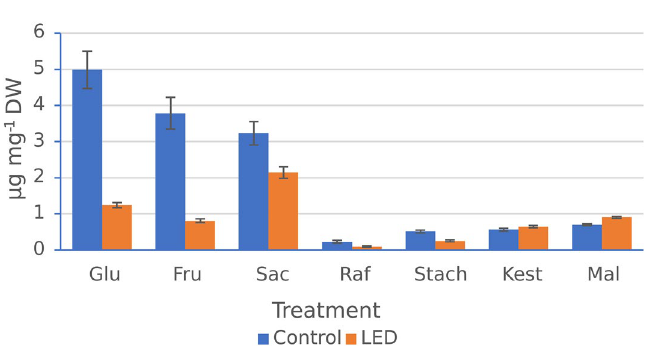
Figure 2. Individual sugar content in leaves of common buckwheat cv. ‘Panda’ under different controlled- environment production systems. Control—solar light supplemented with HPS (High-Pressure Sodium) lamps; LED (Light-Emitting Diodes), Raf—raffinose, Stach—stachyose, Kest—1-kestose, Mal—maltose, Glu—glucose, Fru—fructose, Suc—sucrose. Values represent means ( n = 3) ± SE. Stars indicate significant difference between means; * p < 0.05, ** p < 0.01, *** p < 0.001 (Student’s t